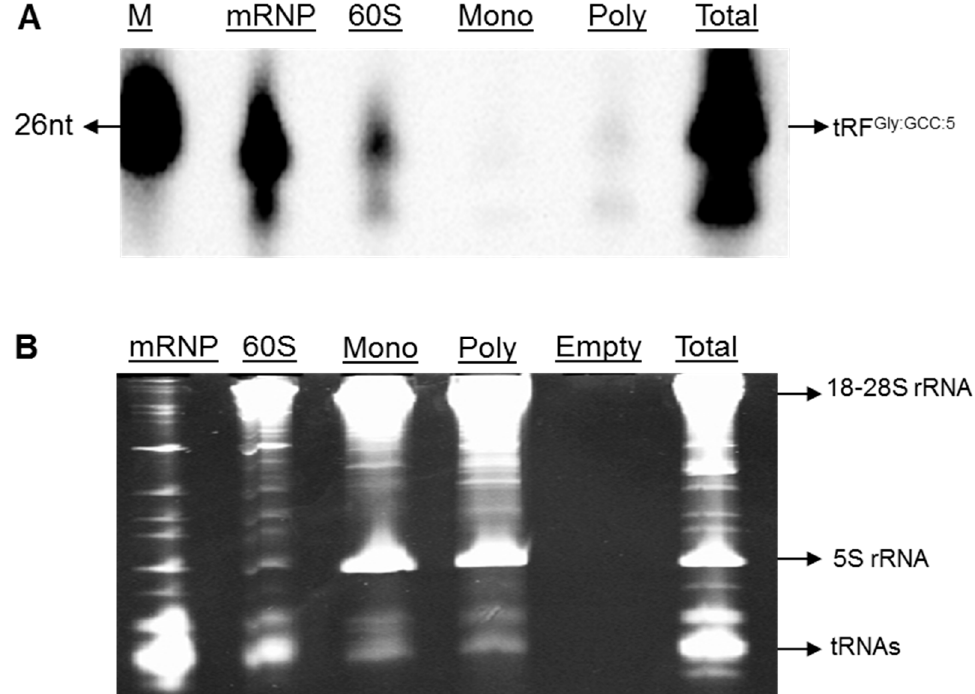
Figure 3. Non-polysomal association of biotinylated-tRF Gly:GCC:5 transfected into S2 cells. ( A ) tRF Gly:GCC:5 was biotinylated at nt-24 (Eurogentec, Belgium) and transfected into S2 cells. 48 h post-transfection with biotinylated-tRF Gly:GCC:5 , S2 cytosolic cell lysates were layered over 5-70% sucrose density gradients. Following centrifugation at 27.000 rpm for 2 h 55 min at 4 °C in a Beckman SW28 rotor, fractions were collected from the top of the gradients using an ISCO density gradient system. Fractions were then pooled into 4 sub-groups based on their A 254 readings; mRNP, 60S, monosome (mono) and polysome (poly). RNA extracted from the fractions or unfractionated cells (Total) were run on 12% denaturing polyacrylamide gel. Streptavidin-conjugated horse radish peroxidase was used to visualize the biotinylated tRFs; ( B ) Ethidium bromide staining of RNAs run on 12% denaturing polyacrylamide gel. M—Marker